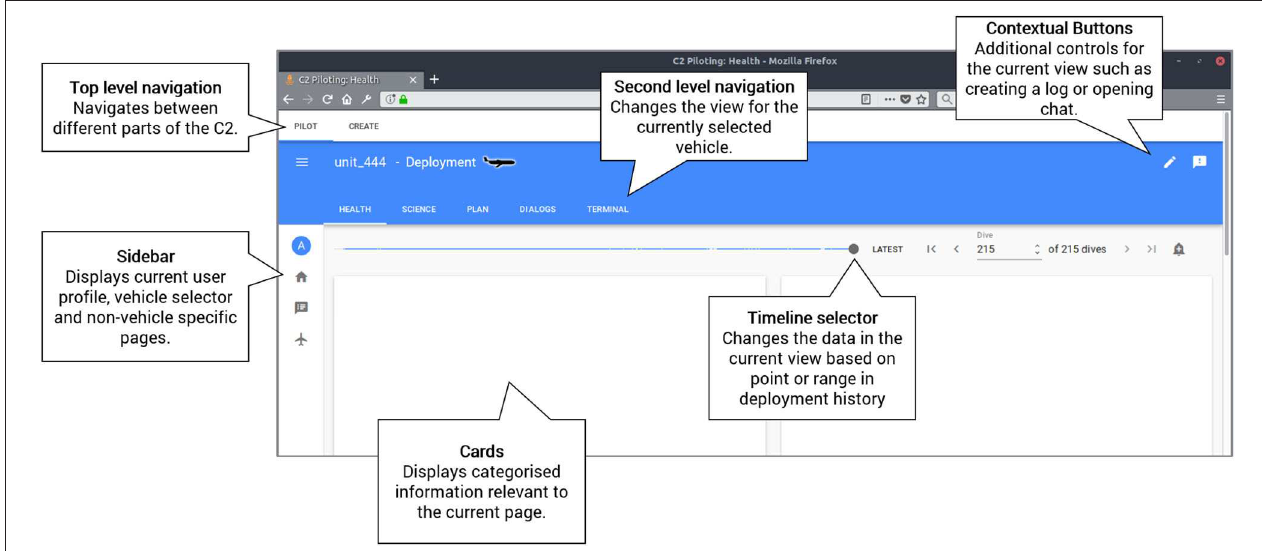
FIGURE 5 | Screenshot of the C2 Piloting Frontend with key design patterns